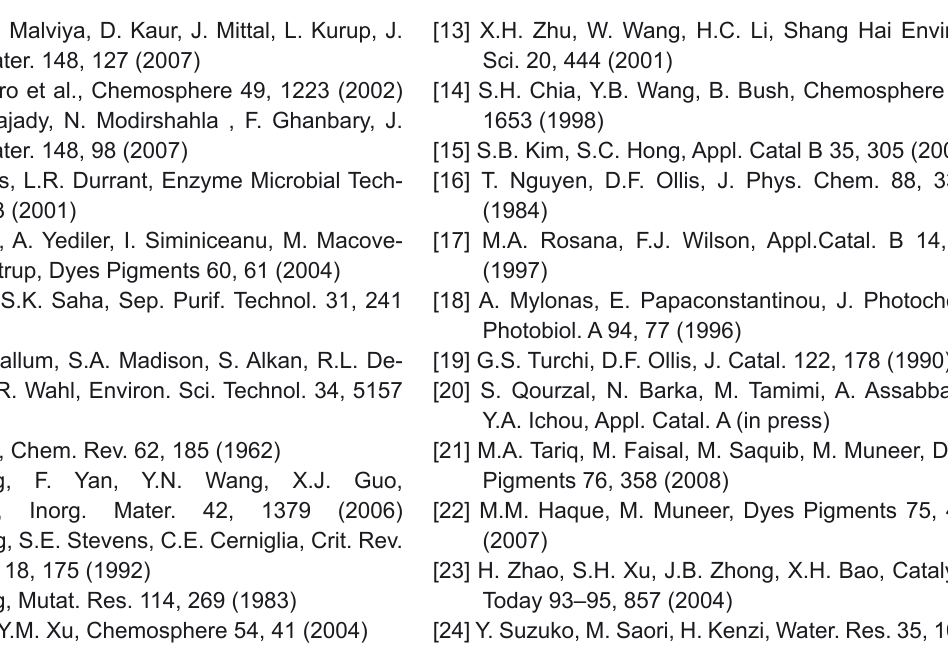
S O +KBr (100 2 2 8